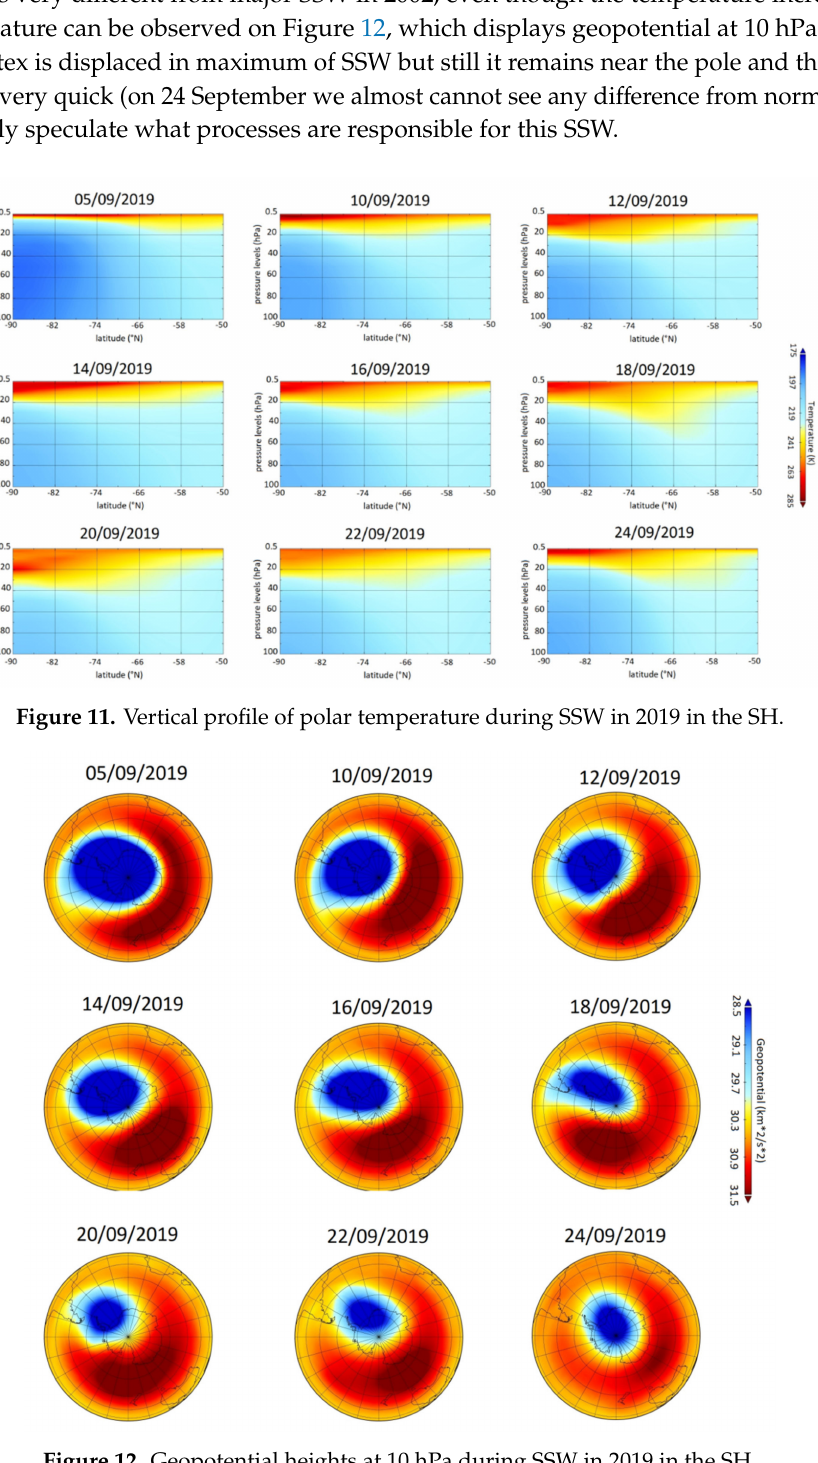
Figure 12. Geopotential heights at 10 hPa during SSW in 2019 in the